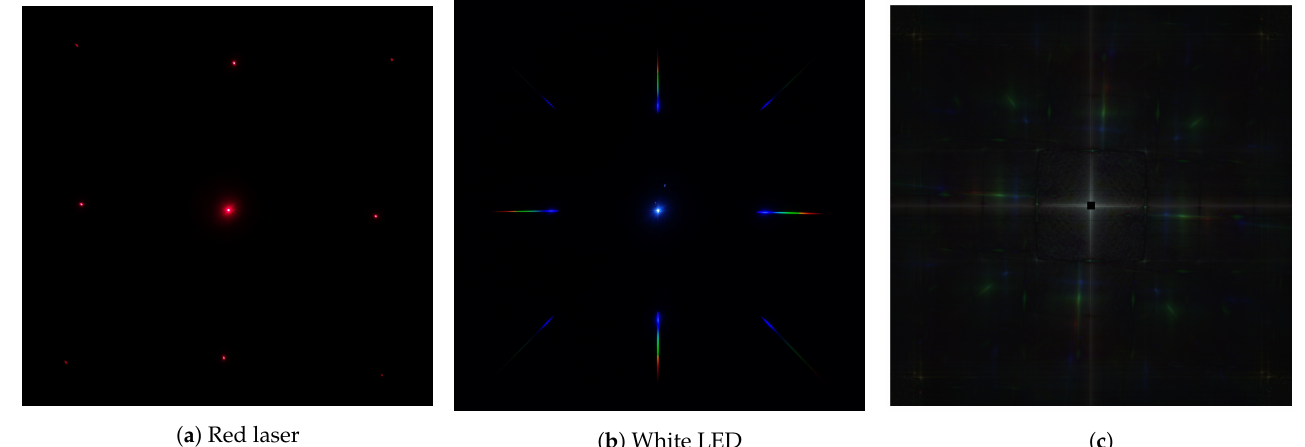
Figure 1. Example diffraction images of point-like light source for ( a ) a red laser and ( b ) a white LED, and ( c ) an example cepstrum image. The diffraction pattern becomes evident when a point-like light source is imaged through a diffraction grating in a dark environment. For ( a ) the red laser, the light is essentially monochromatic, so the diffraction pattern is also point-like. For ( b ), the intensity of the diffraction in for each wavelength is dependent on the diffraction grating efficiency and the spectrum of the light. The diffraction grating used to capture these images is composed of two regular one- dimensional diffraction gratings with their axes at approximately a 90° angle. Due to imperfect alignment, the diffraction pattern is not entirely symmetrical. ( c ) The example mean cepstrum image formed from the mean of 60 cepstrum images of a diffused RGB illuminant captured using a Canon M3 camera combined with a diffraction grating, a Sigma 35 mm lens, and a field stop construct attached in front of the lens. The resulting cepstrum image was shifted such that the center of the cepstrum image is displayed in the center of the image. The center of the image was masked out as it contains high intensity pixels that are not relevant to spectrum extraction. Figure best viewed in color.